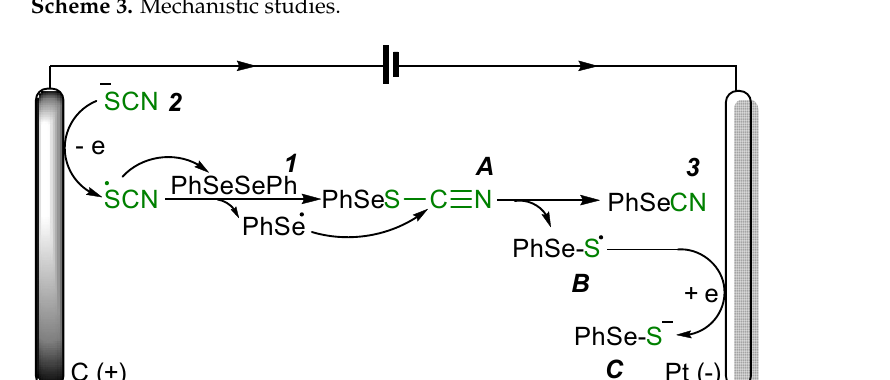
Figure 1. Cyclic voltammetry experiments.